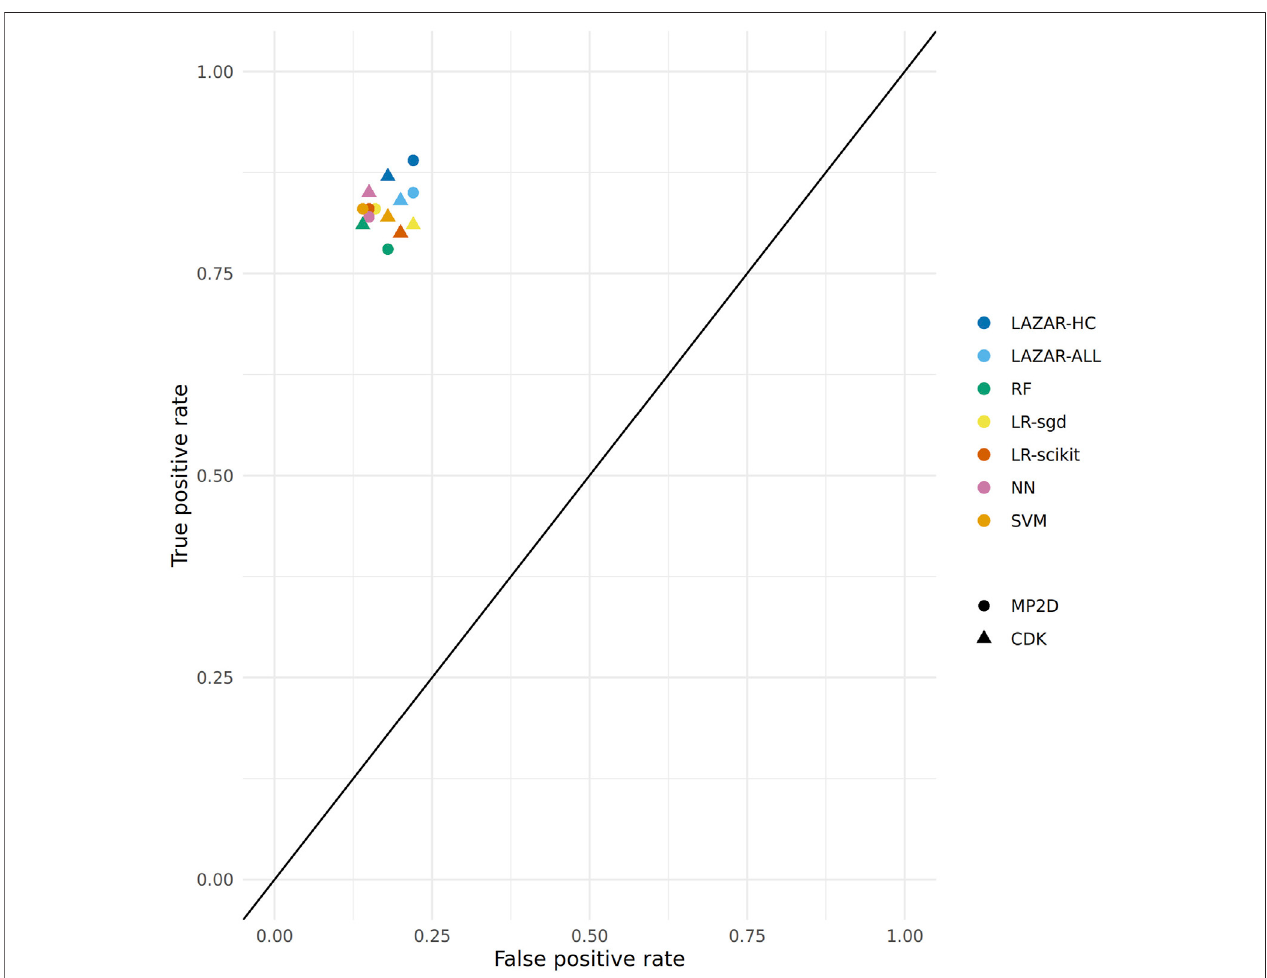
FIGURE2| ROCplot ofcrossvalidationresults (lazar-HC, lazar withhigh con fi dence, lazar-all: alllazar predictions,RF, random forests,LR-sgd,logisticregression (stochastic gradient descent), LR-scikit, logistic regression (scikit), NN, neural networks, SVM, support vector machines).